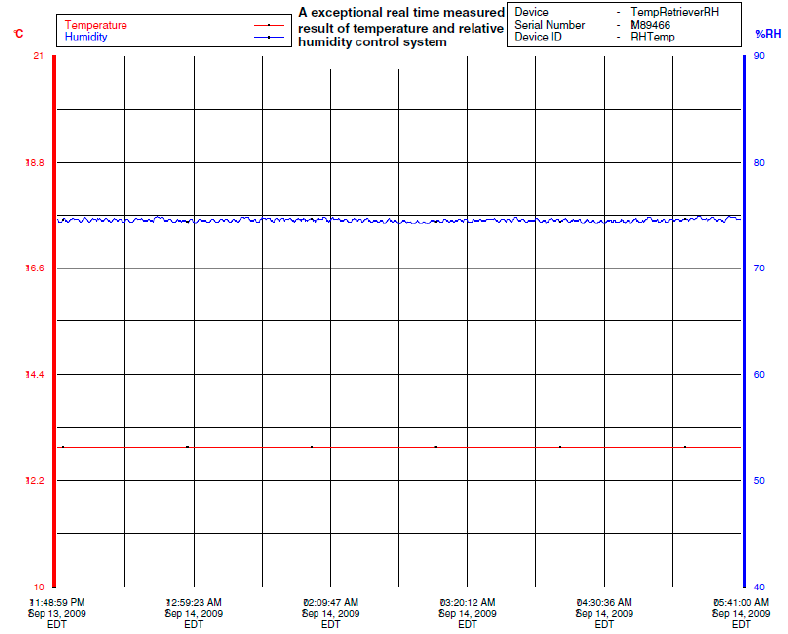
Figure 10. The temperature and relative humidity under closed loop control based on meticulous setup.